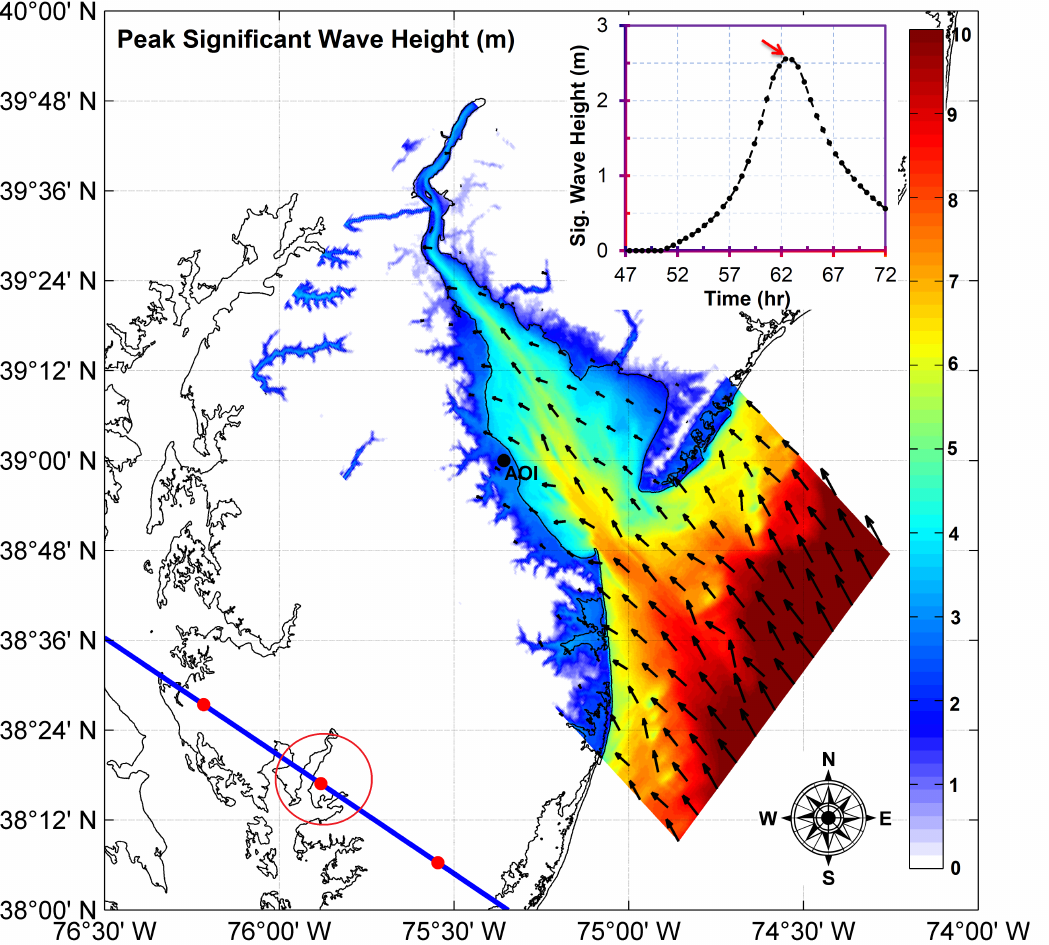
Figure 11. Significant wave height (m) and direction snap-shot from Nested2 model at the time of the maximum wave. Time history of significant wave height ( top right ). Synthetic hurricane track is shown in blue color line with the hourly location of the storm center in red filled circles ( bottom left ). The location of hurricane center at the time of this plot is identified with a red